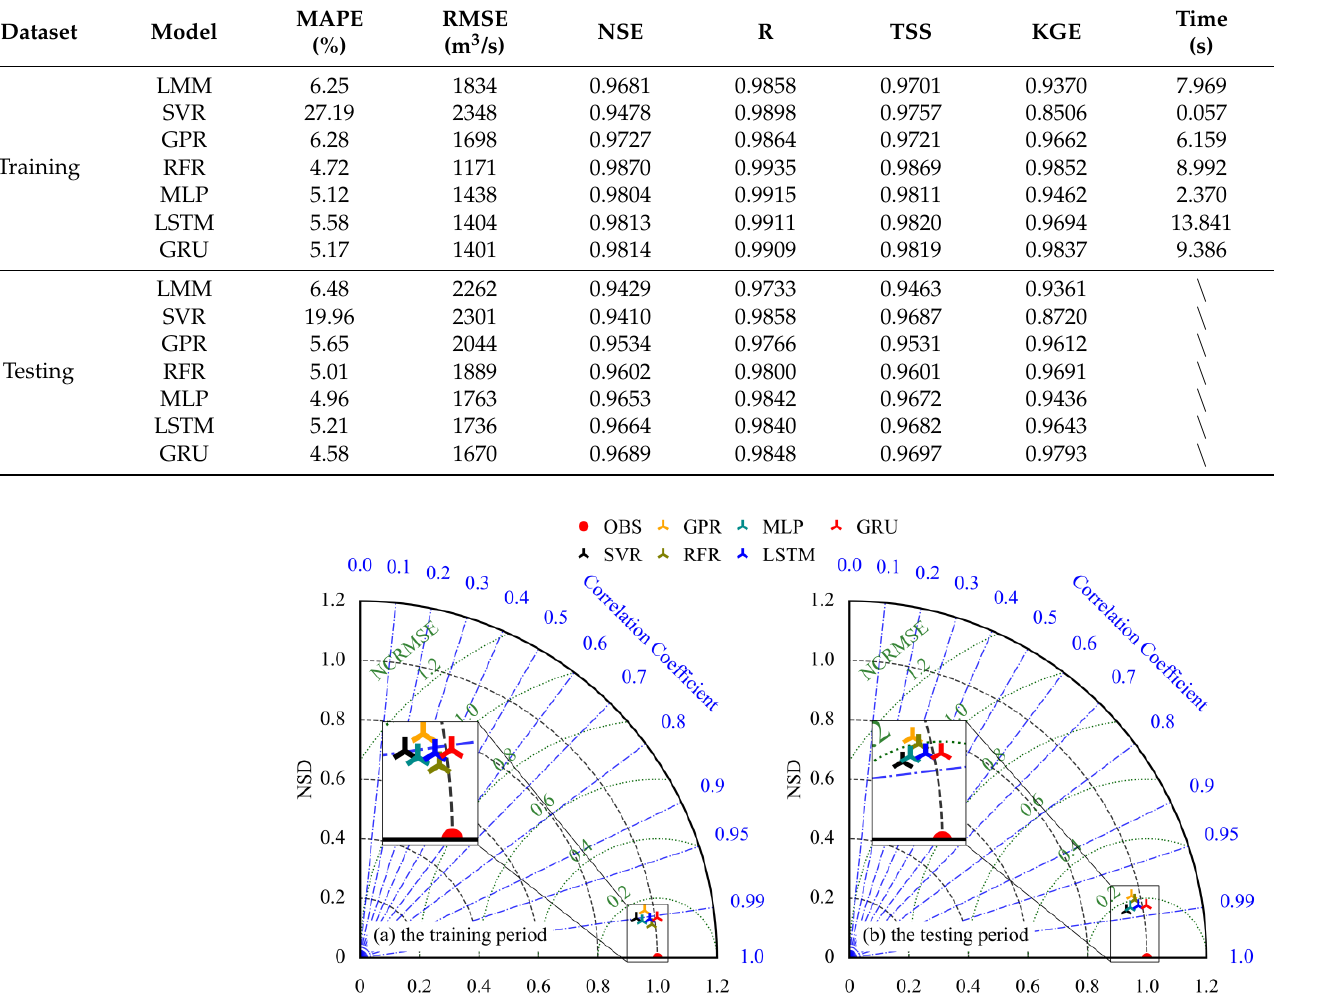
Figure 3. Taylor diagram depicting the performance of six ML models for inflow hydrograph prediction of the TGR.